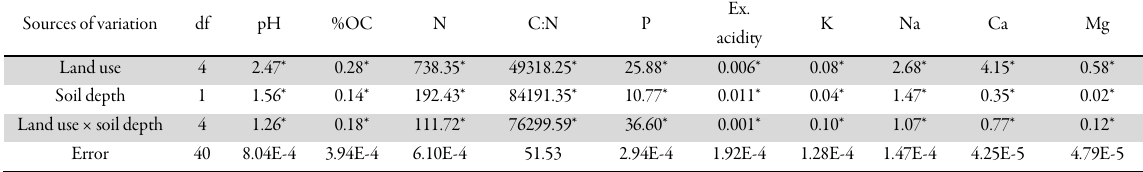
Table 2. Results of analysis of variance and mean squares of soil chemical properties at two soil depths in five different land use types at two soil depths Sources of variation df